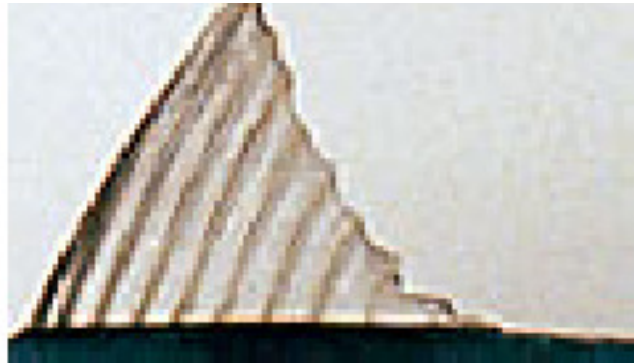
Figure 8. The region where spines were